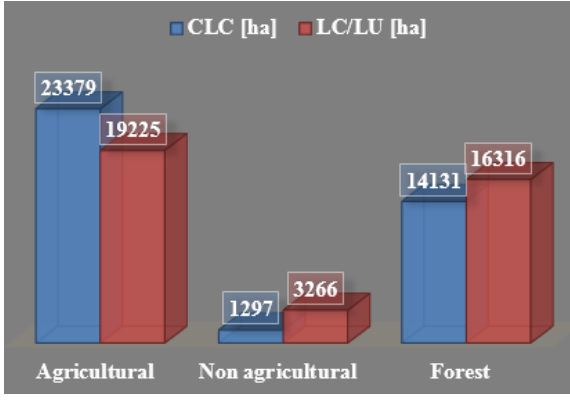
Figure 5 . The comparison between 3 macro classes